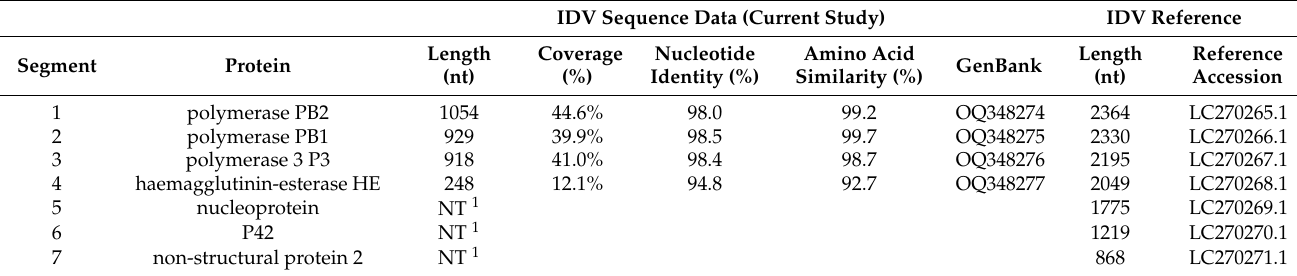
Table 2. Summary of the bovine influenza D virus partial genomic segment sequences identified in the current study, as compared to the strain IDV